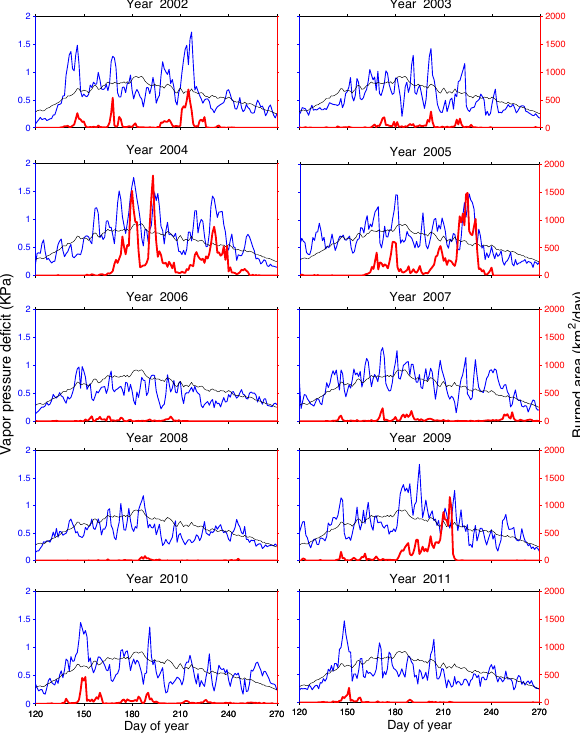
Figure 9. Times series of daily VPD (blue; left axis) and burned area (red; right axis) for interior Alaska. Domain-wide mean annual daily VPD from 1979–2011 is also shown in black (left